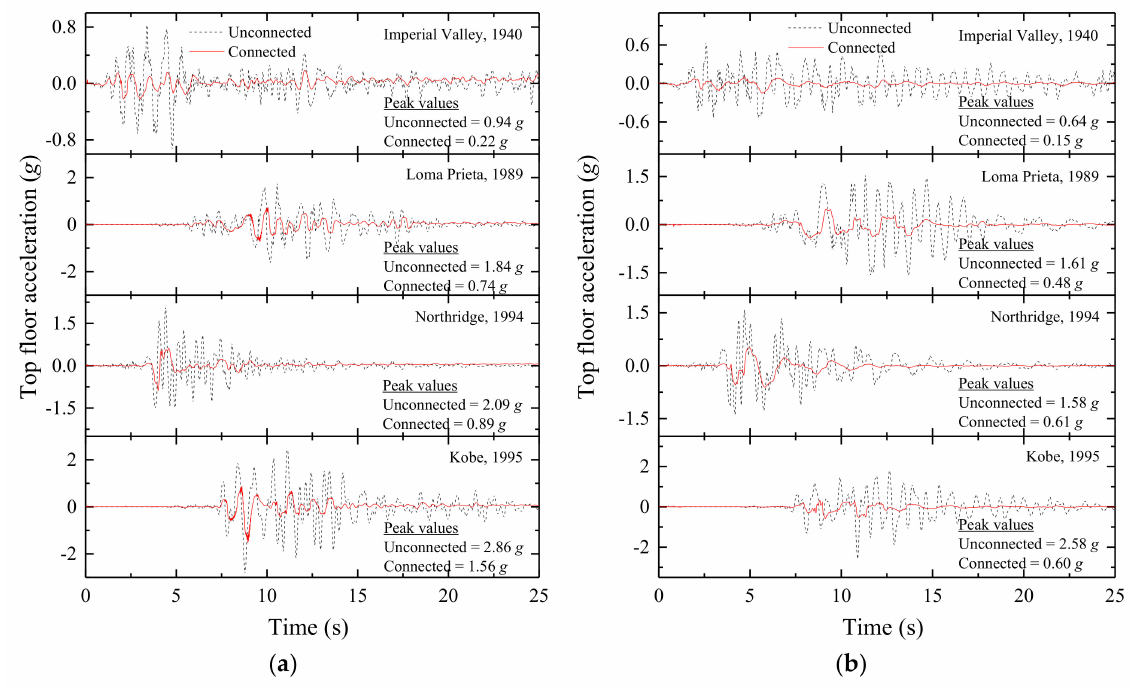
Figure 9. Time history of absolute top floor acceleration in: ( a ) a coupled stiff building and ( b ) a cou- pled flexible building when semi-active MR dampers are used as coupling devices in Configuration